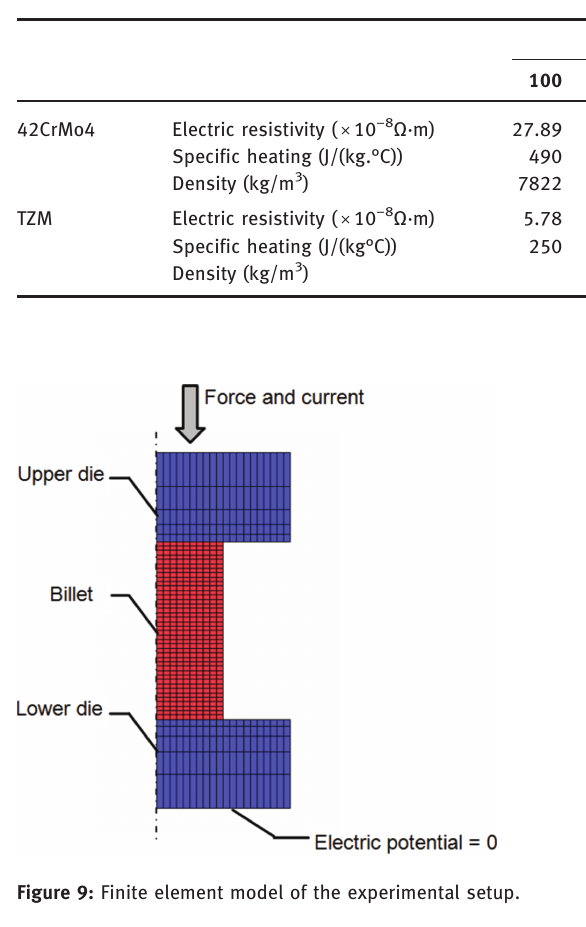
Table 2: Material properties for the